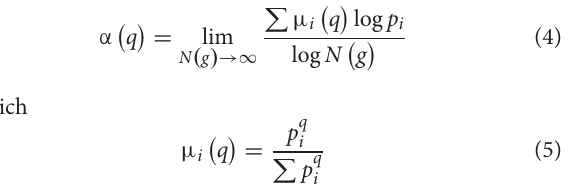
Frontiers in Physiology |